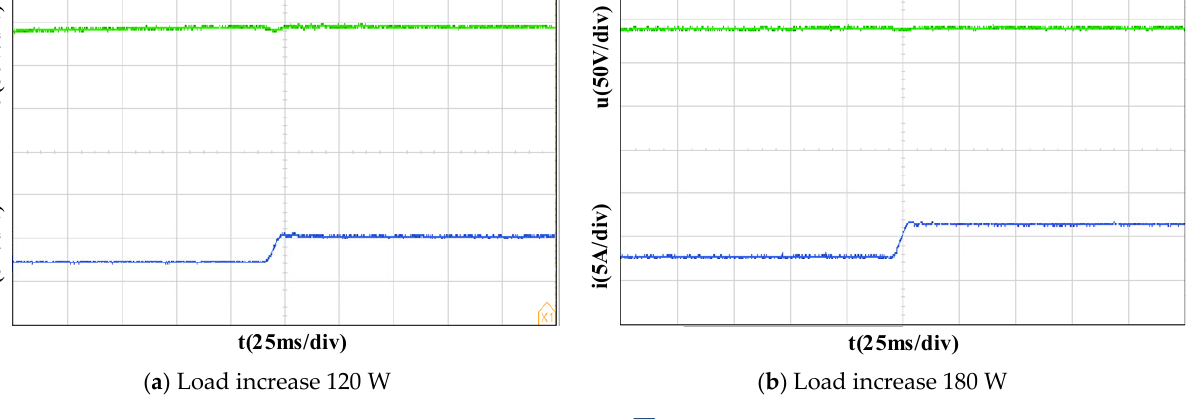
Figure 7. Experimental platform picture. The bidirectional DC/DC converter adopted a single pole PWM trigger method. The power drive chip IR2104 and the optocoupler chip 6N137 were used to design the PWM power drive circuit. The advantages of IR2104 driver chip are its strong driving ability and high cost ‐ effectiveness. The MOS tube of the bidirectional DC/DC converter was se ‐ lected as SiC N ‐ Channel MOSFET . This MOS tube is suitable for advanced high ‐ effi ‐ ciency switching applications. Figure 8 is the response waveform of the DC bus voltage and the battery terminal current when the load suddenly increases under different load conditions.